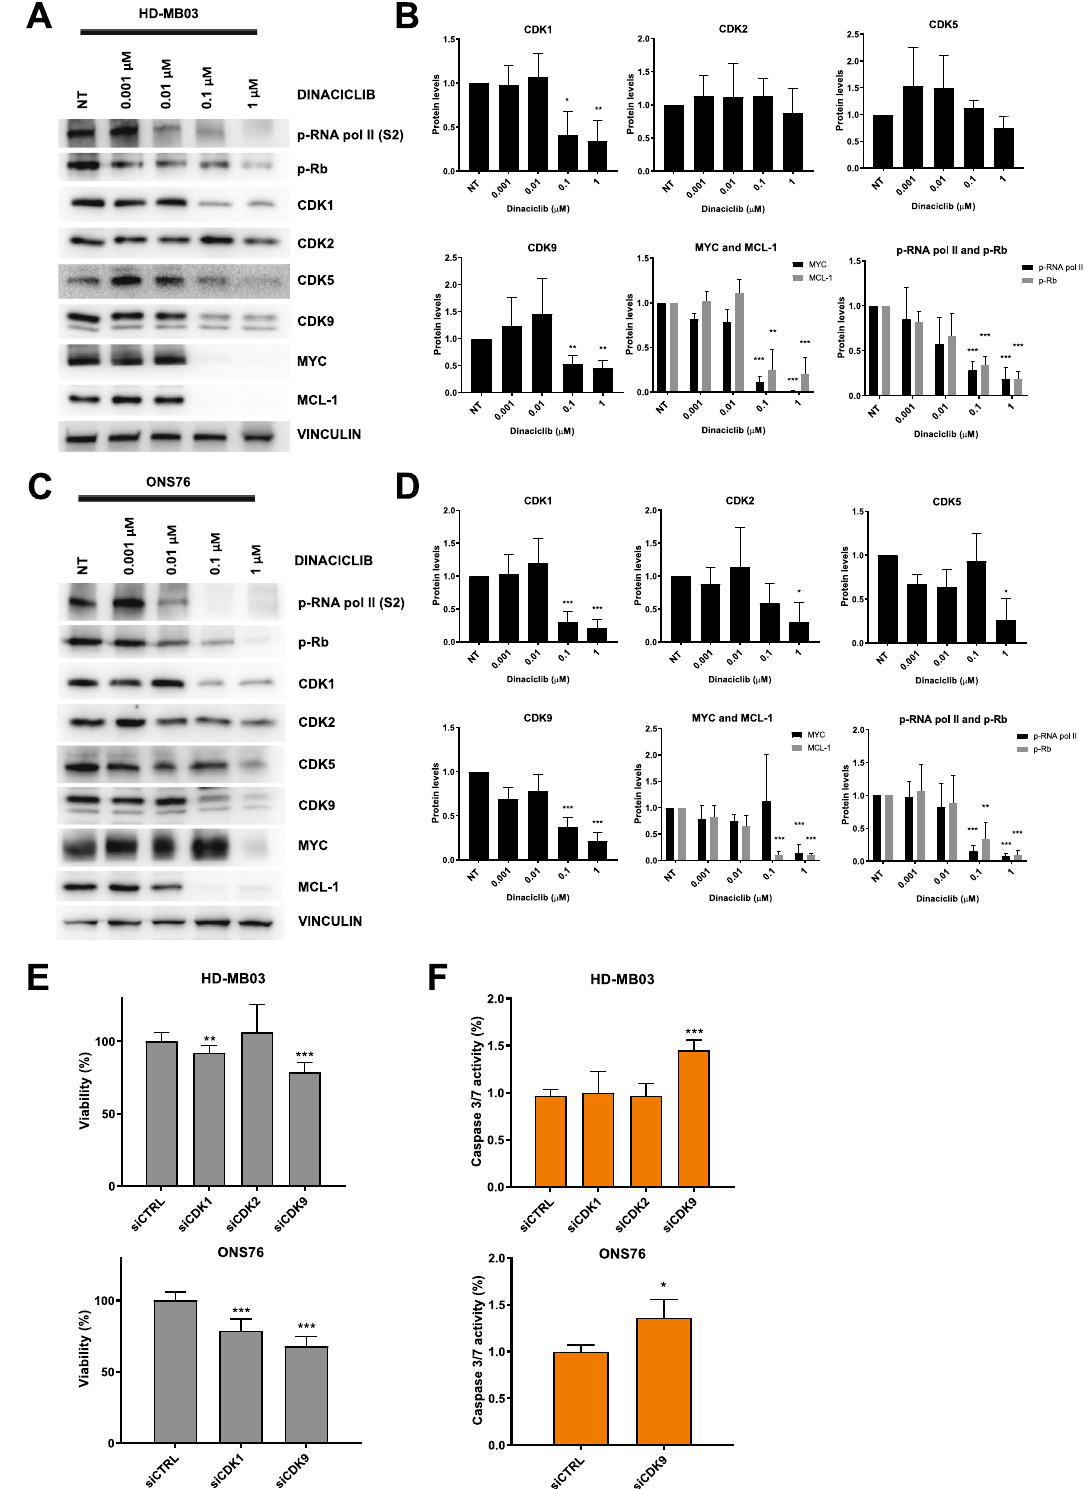
Figure 5. Mediators of cytotoxic effects by dinaciclib in medulloblastoma. ( A ) HD-MB03 cells were treated with indicated doses of dinaciclib for 24 h. Cell extracts were analysed by Western blotting. ( B ) Densitometric analysis of blots presented in ( A ) the other original blots used for the analyses can be found in Supplementary Fig. S3A. ( C ) ONS76 cells were treated with indicated doses of dinaciclib for 24 h. Cell extracts were analysed by Western blotting. ( D ) Densitometric analysis of blots presented in C) the other original blots used for the analyses can be found in Supplementary Fig. S3B. ( E ) Proliferation assay of HD-MB03 and ONS76 cells transfected with siCDK1, siCDK2 or siCDK9 relative to untransfected control (siCTRL). ( F) Caspase 3/7 activity in HD-MB03 and ONS76 cells treated as above. Values are relative to untransfected control. Statistical comparisons were performed using an unpaired, two- tailed Student t-test where * P < 0.05; ** P < 0.01; *** P < 0.001. Plotted graphs show mean ± SD (n =